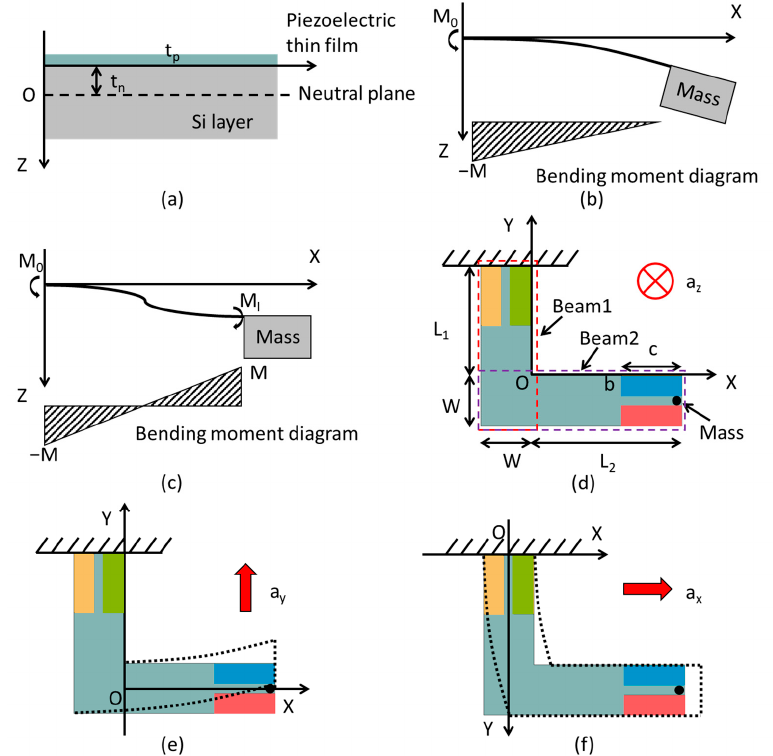
Figure 2. ( a ) Cross-sectional area of the suspended piezoelectric/silicon beam in the thickness direction of the device. Two deformations of the cantilever: ( b ) the direction of the bending moment of the beam is all same (Type 1); ( c ) the direction of the bending moments at both ends of the beam are opposite (Type 2). Schematic diagram of the tri-axial piezoelectric accelerometer when z -axis ( d ), y -axis ( e ), and x -axis ( f ) accelerations are applied respectively.